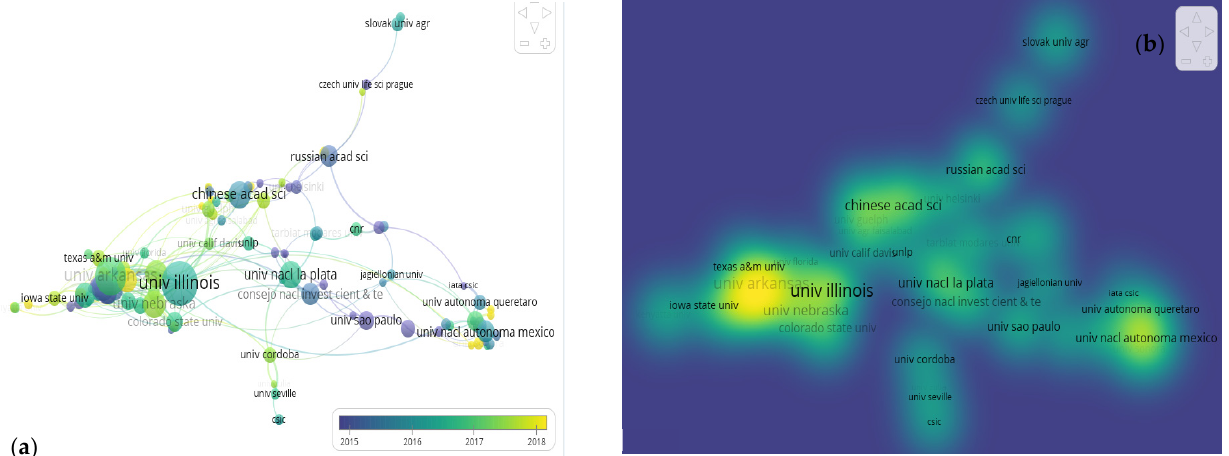
Figure 5. Co-authorship institutions on Amaranthus research overlay visualization ( a ), density visualization ( b ). Co-authorship countries.